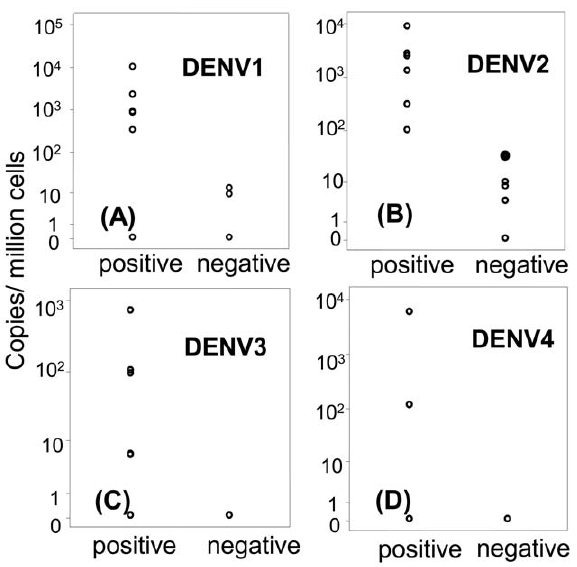
Figure 3. Positive and negative strand DENV RNA levels in unfractionated PBMC. Quantitative PCR for positive and negative strand viral RNA was performed with RNA extracted from unfraction- ated PBMC collected on fever day-2 from subjects infected with DENV1 (A), DENV2 (B), DENV3 (C), or DENV4 (D). The range of the positive strand DENV RNA was 0 to 6069 copies/million cells. Negative strand DENV RNA was detected in 6 of 18 samples with detectable positive strand RNA and the levels ranged from 5 to 35 copies/million cells.